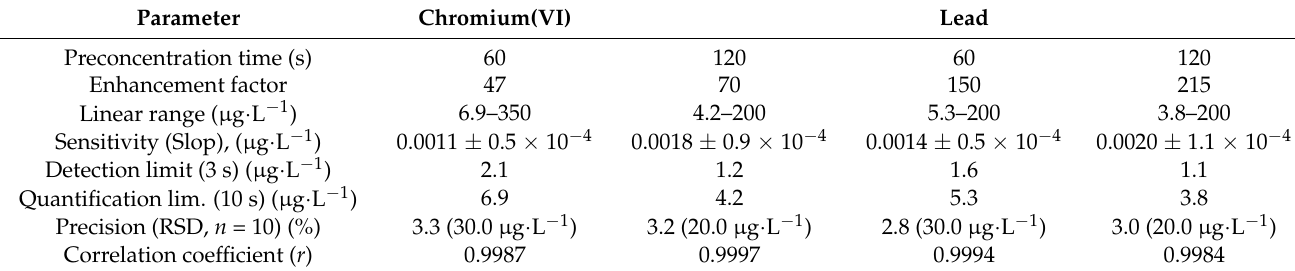
Table 2. Analytical features of the FI-FCSE-FAAS method for lead and chromium(VI) determination. Parameter Chromium(VI)